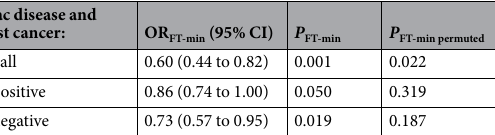
Table 1. Inverse genetic correlation for the SNPs subset yielding most significant association (minimum discordance). Genetic correlation estimates by SECA Fisher’s tests (FT) identifying minimum discordance (FT-min) in subsets of overlapping SNPs between breast cancer and celiac disease. OR and its CI range is presented for the SNP subsets yielding minimum discordance, which refers to the SNP subset with the lowest Fisher’s P-value ( P FT-min ). P-value was adjusted for multiple testing by a permutation procedure ( P FT-min permuted